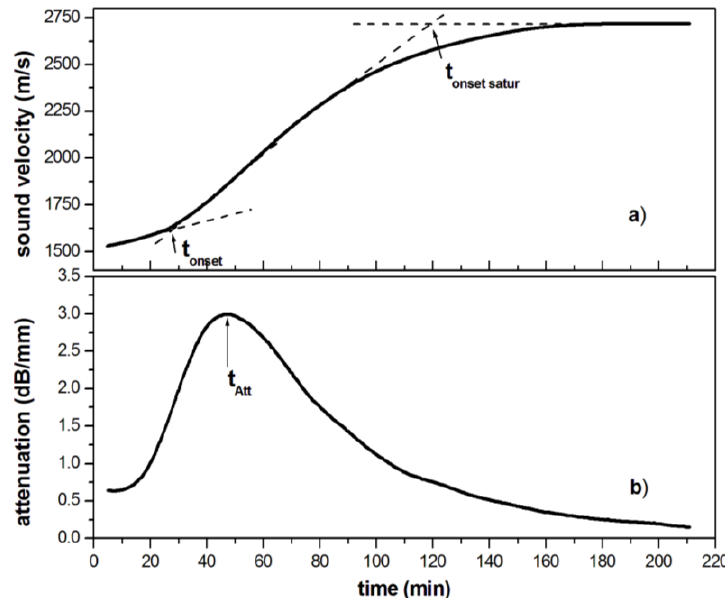
Figure 2. ( a ) Longitudinal velocity; and ( b ) attenuation measured at 2 MHz during the isothermal cure of an unsaturated polyester resin at 30 °C.